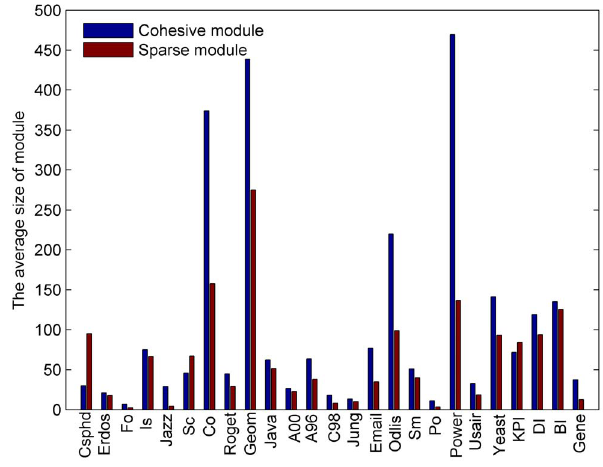
Figure 4. The average sizes of sparse and cohesive modules in various